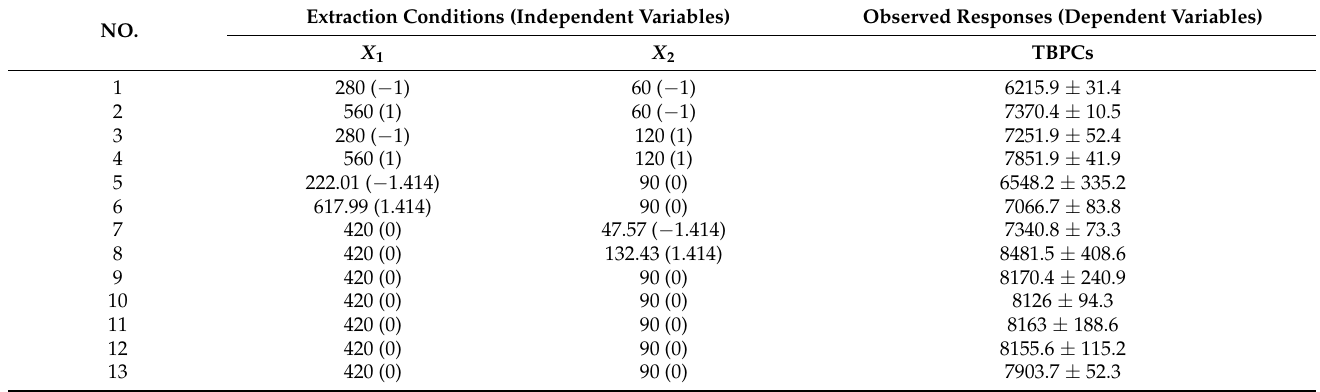
Table 5. The MAE experimental design in coded and uncoded form for the optimization of variables using CCD.